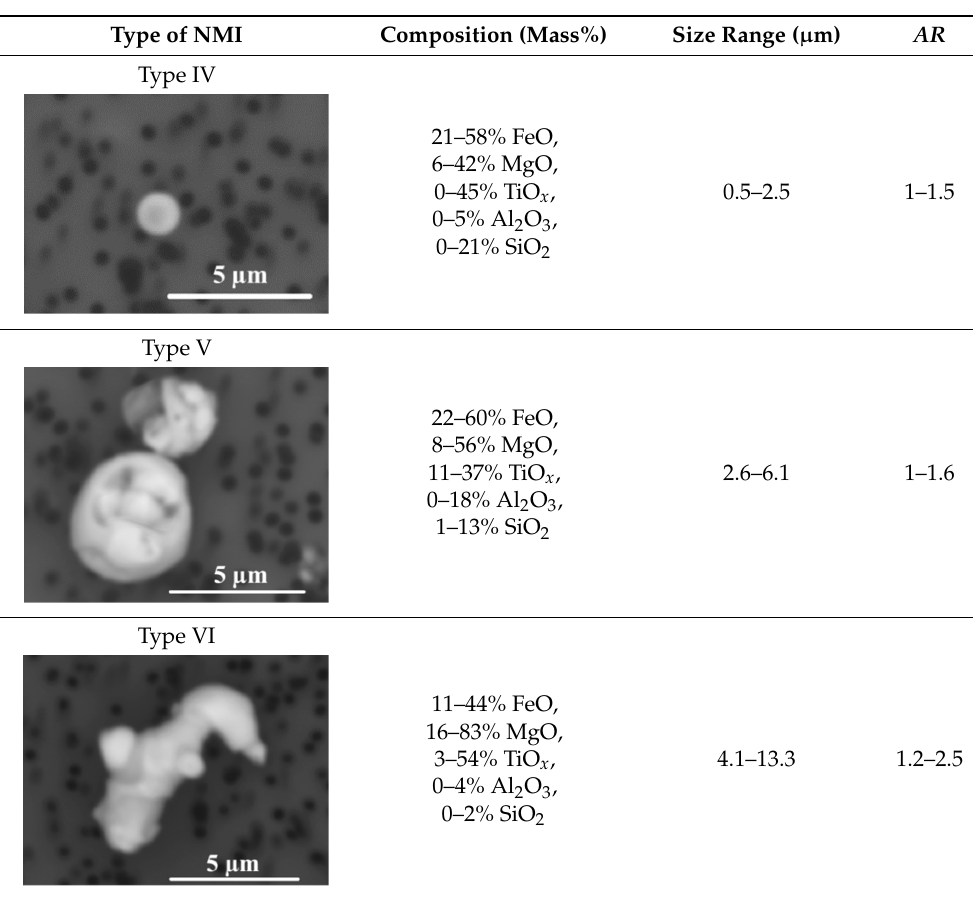
Table 6. Classification of main oxide inclusions in the Ti/Mg experiments by using FGA measure- ments.